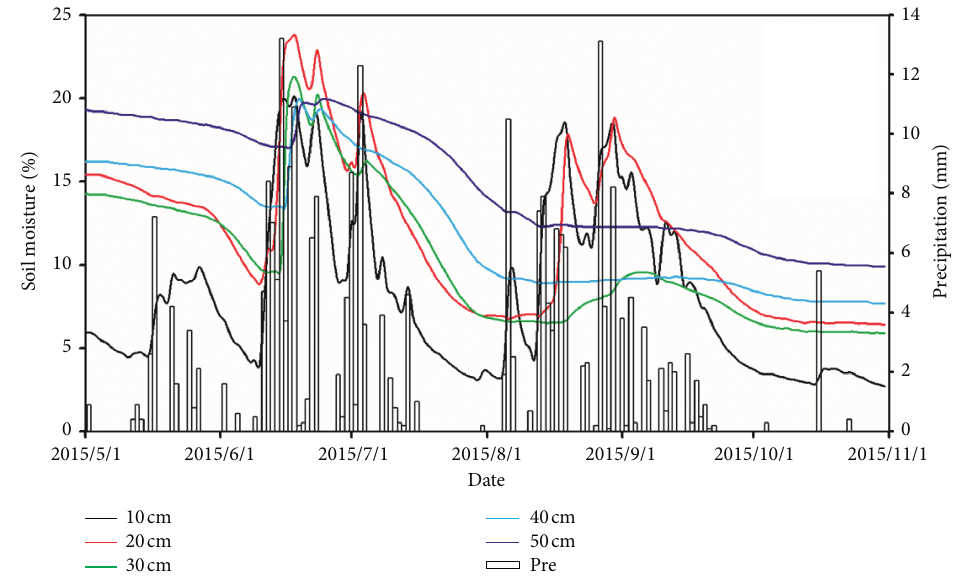
Figure 5: Precipitation and SM levels in the soil profile at Naqu from May to October 2015. Table 1: Correlations between precipitation and SM through the soil profile at Naqu. Precipitation 10 cm